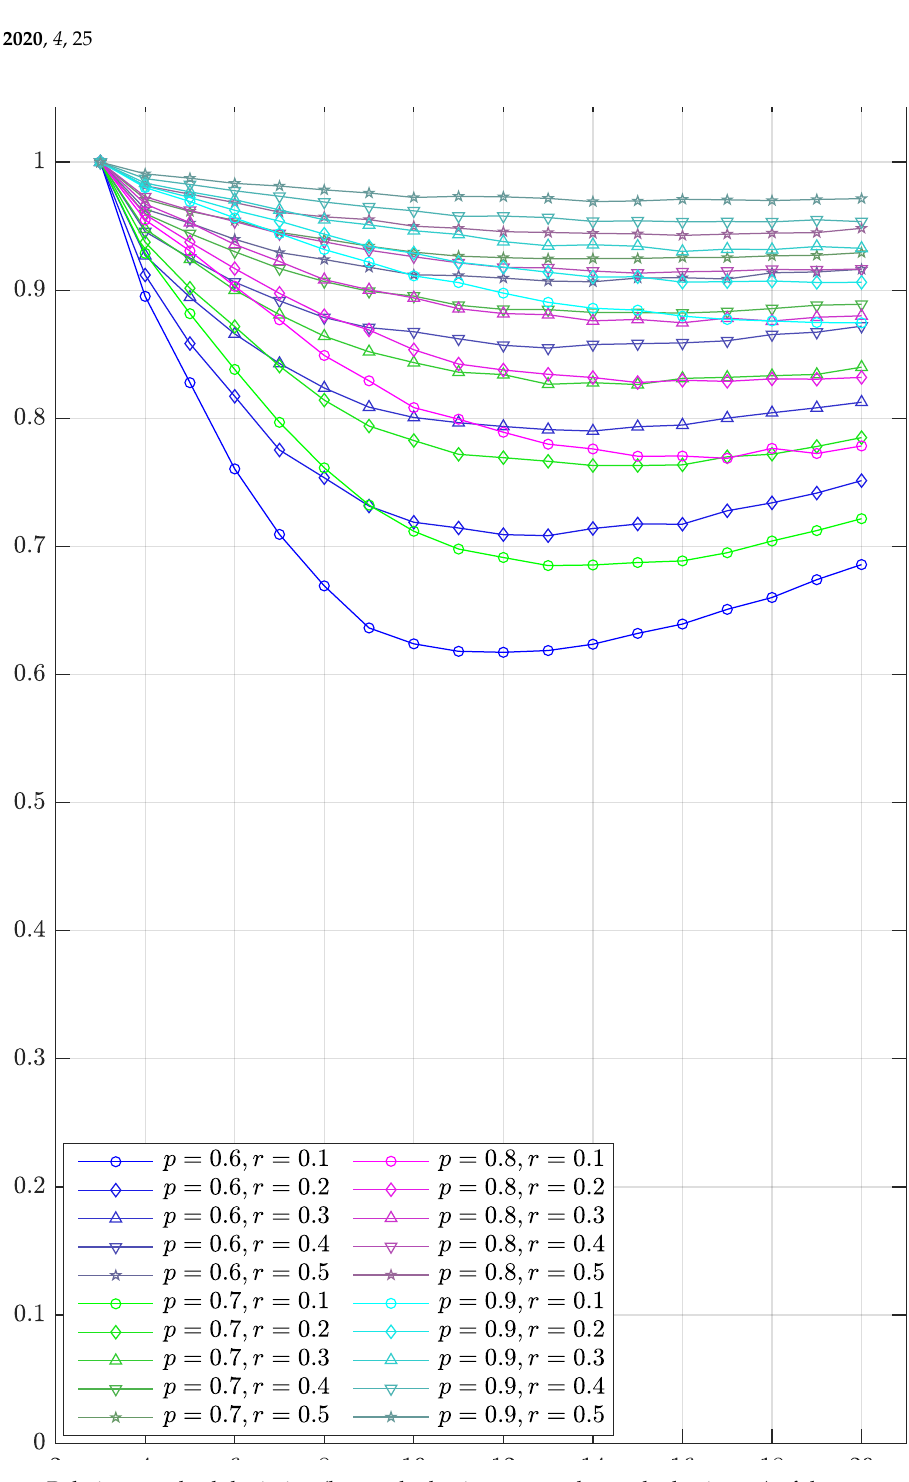
Figure 9. Relative standard deviation (heteroskedastic rms over homoskedastic rms) of the curvature κ for p T = 20,GeV/ c , λ = π /4 and all 20 combinations of p and r in the range 3 ≤ n ≤